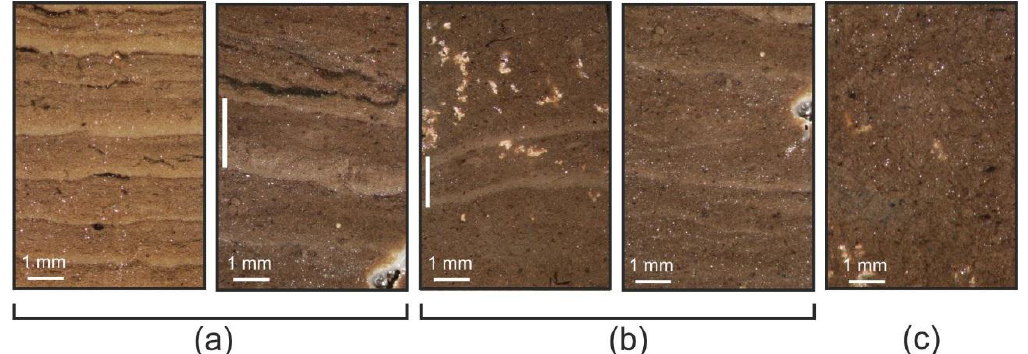
Figure 3 . Examples of different sediment types in incident light microscopy images. ( a ) Varved 181 sediment: continuous varved section (left) and one clastic-organic couplet (right; marked with a white 182 bar). ( b ) Partially varved sediment with unclear contacts and disturbed or discontinuous lamina. 183